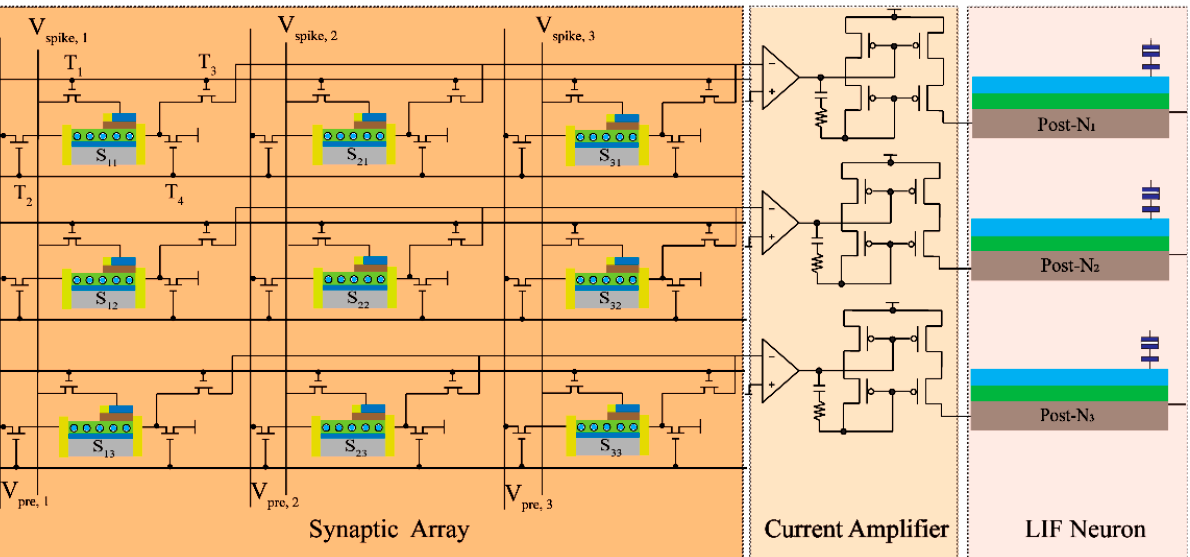
Figure 4. Illustration of the 4T1R architecture and the 4-cell-4T1R cell array of the proposed skyrmion-based SNN. The architecture consists of a synaptic array and LIF neurons connected by the current amplifier.